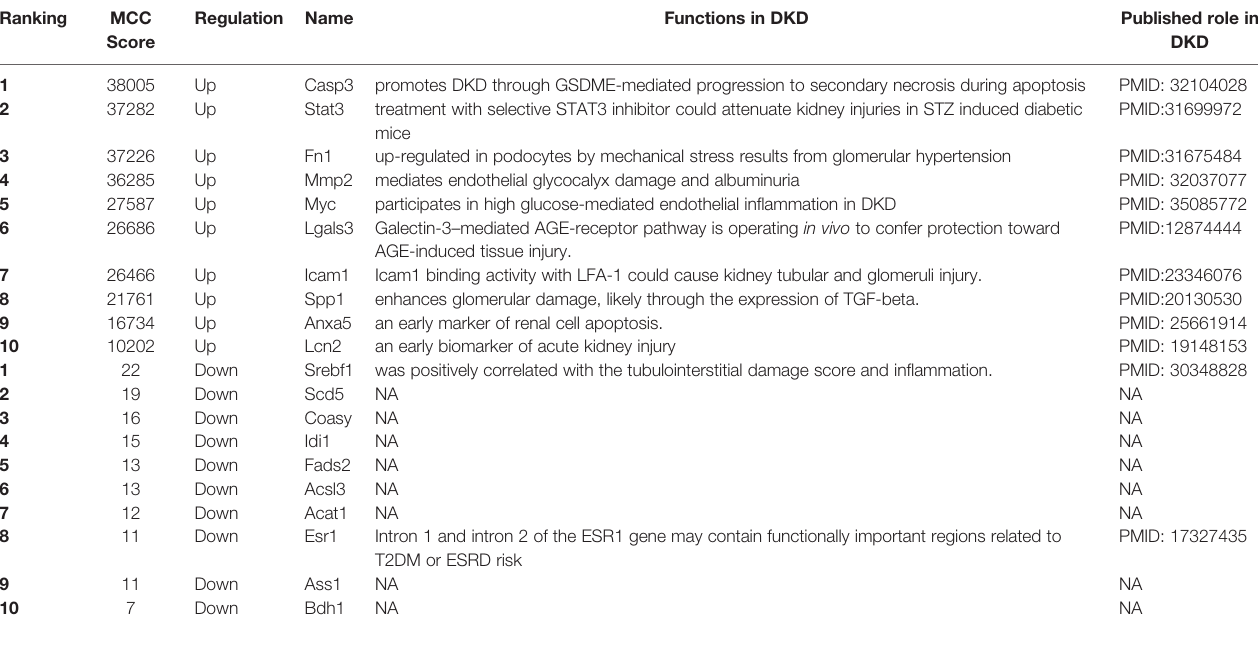
TABLE 3 | The top 10 shared up-and down-regulated hub genes found in the PPI network.